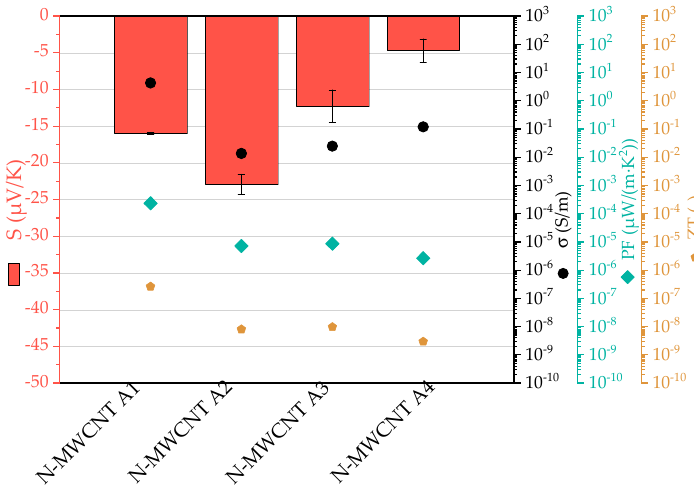
Figure 1. Thermoelectric properties (40 °C) of polypropylene (PP)/5 wt% nitrogen-doped multi-walled carbon nanotubes (N-MWCNT) composites filled with different kinds of N-MWCNT (listed in Table 1).